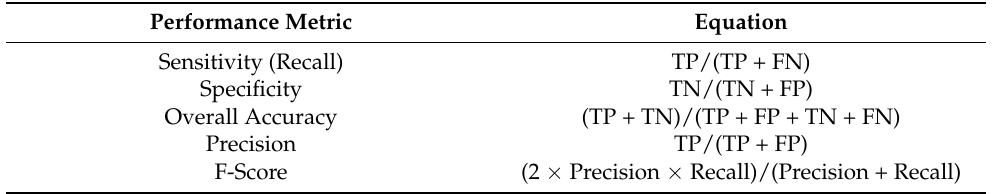
Table 2. Performance measurements derived from the confusion